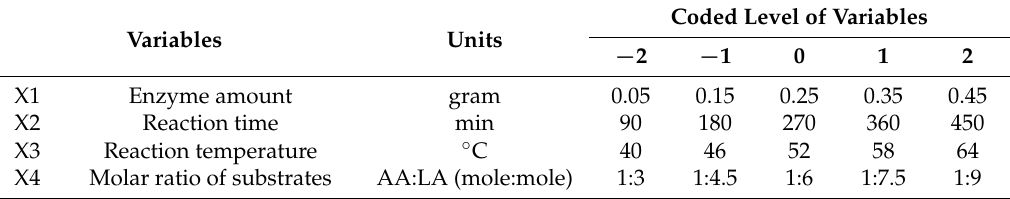
Table 1. Variables and their levels employed in the central composite rotatable design.